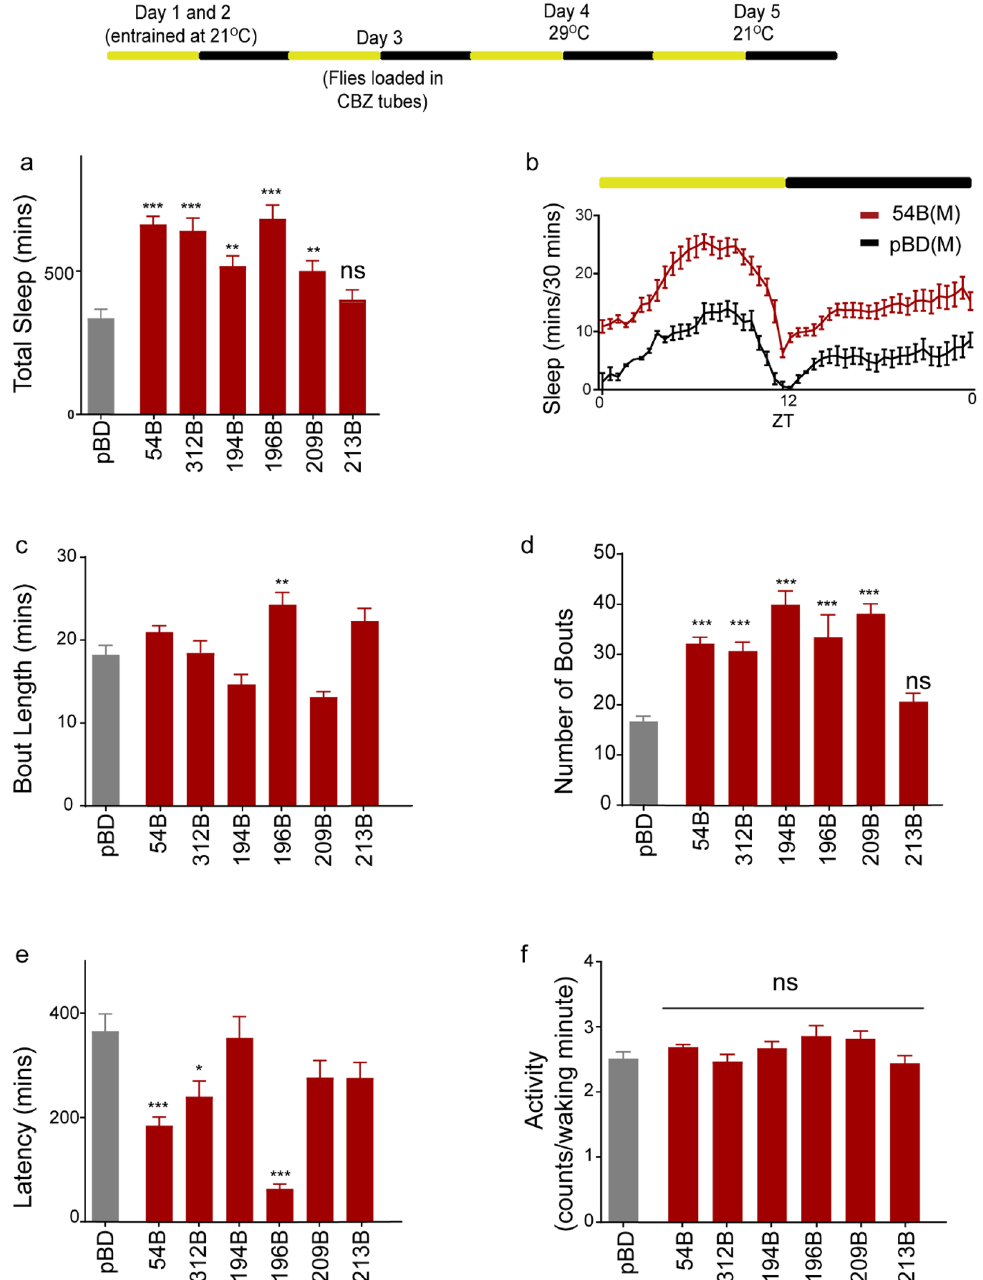
Figure 4. Wakefulness induced by pharmacologic suppression of GABA A receptor, Rdl requires specific subsets of MB DANs. Schematic of experimental protocol showing temperature and drug conditions over a 5-day period. Flies were entrained for Day 1 and 2 in vials. Following entrainment flies were loaded on CBZ containing food (Day 3) in incubator maintained at 21 °C. Day 4 the temperature was switched to 29 °C and used for quantification and analysis shown below. ( a ) Total sleep in PAM-DAN subsets (red) labelled by split-GAL4 lines, MB054B, MB312B, MB194B, MB196B, MB209B, and MB213B where neural activity has been suppressed by over-expressing temperature sensitive dominant negative dynamin mutation, Shi ts1 in the presence of CBZ (Day 4). Enhancerless/empty-GAL4 in the same genetic background as PAM split-GAL4 lines was used as control (grey). ( b ) Representative sleep profile of flies on Day 4 with targeted inhibition of specific PAM MB054B (red) and empty/enhancerless-GAL4 control (black). ZT indicates zeitgeber time where ZT 0: lights on and ZT 12: lights off. ( c , d ) Average bout length (minutes) and average number of bouts on day 4. ( e ) Sleep latency or time to sleep from lights off (ZT 12) was calculated as the time gap in minutes between lights off and first sleep bout. ( f ) Activity or average beam crossings/ waking minute indicative of locomotor activity of all tested genotypes. For each of the experimental groups we had 73–98 flies which represents 4 independent experimental trials. Number of flies for each genotype were: pBD (n = 96), 54B (n = 98), 194B (n = 77), 209B (n = 81), 213B (n = 73), 312B (n = 82), and 196B (n = 75). In this and all subsequent figures data represents mean and SEM, * indicates p < 0.05, ** indicates p < 0.001 and *** indicates p < 0.0001. Statistical analysis was one-way ANOVA and Dunnett’s paired comparison with control for ( a , e , f ) and Kruskal–Wallis non-parametric one-way ANOVA and Dunn’s post- hoc correction for ( c , d